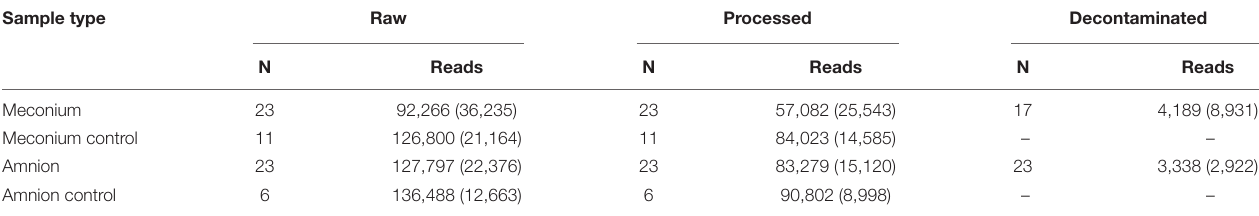
TABLE 1 | Mean read counts (standard deviation) detected in meconium and amniotic fluid samples and their negative controls. Sample type